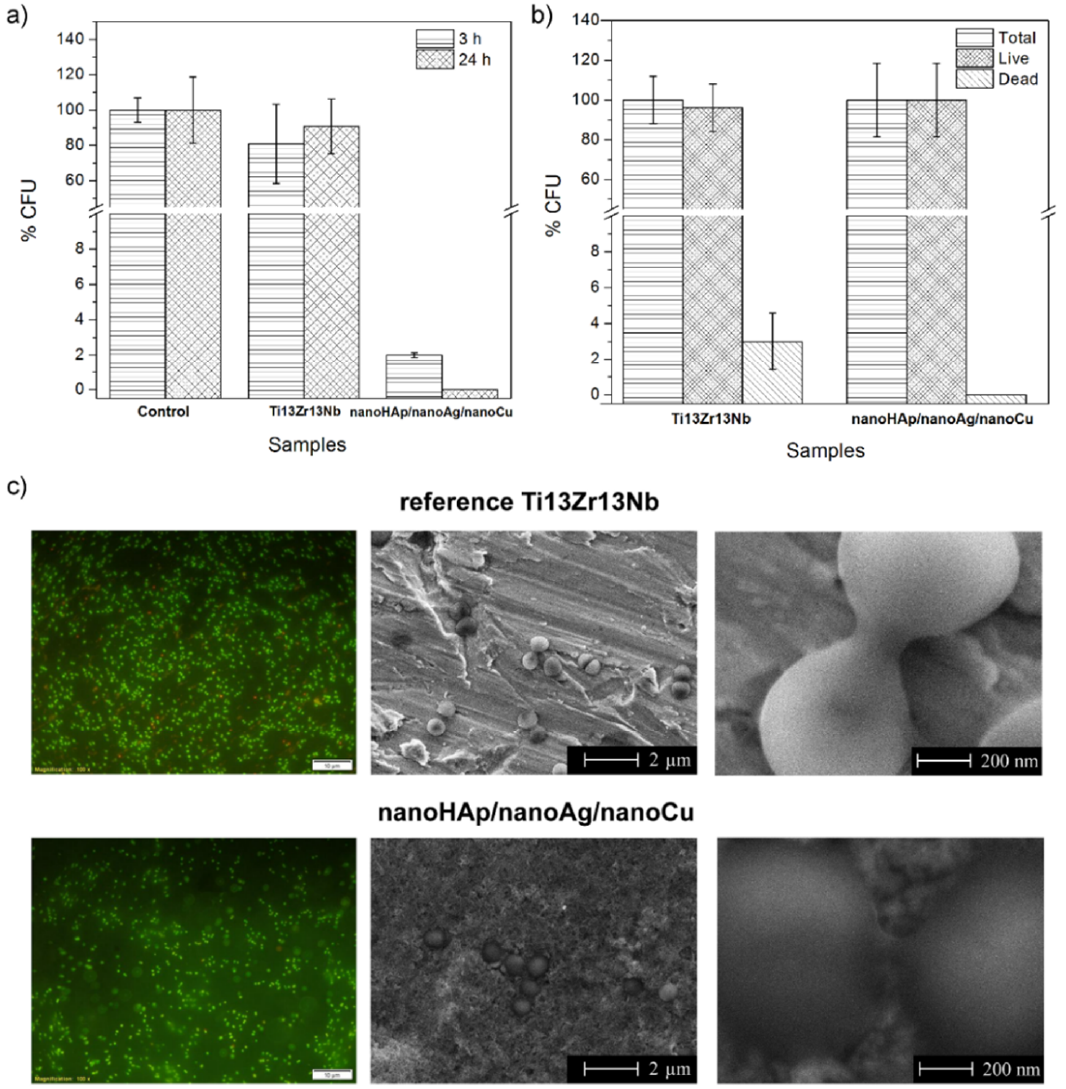
Figure 3. Survival of S. aureus cells after incubation of the bacterial cell suspension with tested surfaces for 3 h and 24 h ( a ), amount of S. aureus cells adhered to the tested samples after 1.5 h of incubation ( b ), and S. aureus cells’ presence on the reference Ti13Zr13Nb alloy and nanoHAp/nanoAg/nanoCu coatings after 1.5 h of contact (fluorescent microscopy—magnification 100× and SEM images with different magnifications) ( c ).